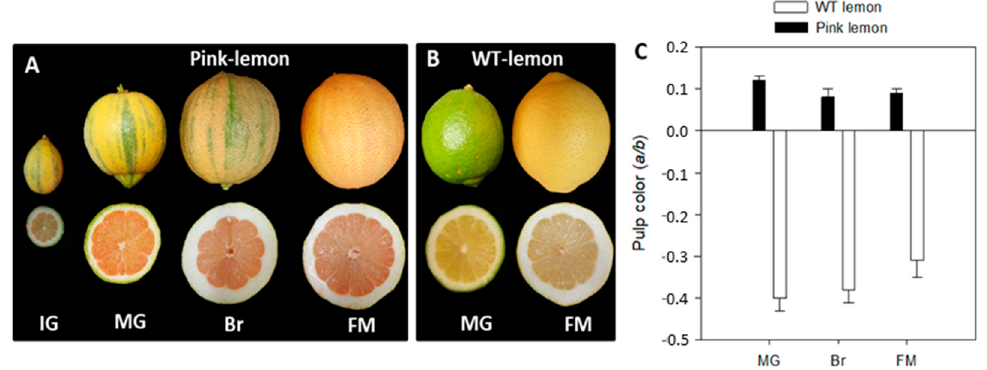
Figure 2. External and internal appearance of pink lemon (PL) ( A ) and wild-type (WT) ( B ) lemon fruit during development and maturation. Immature green (IG), mature green (MG), breaker (BR) and fully mature (FM) stages. Changes in color (a / b Hunter) of the pulp of PL and WT ( C ) during fruit maturation. Data are the mean ± SD of at least 10 fruits.